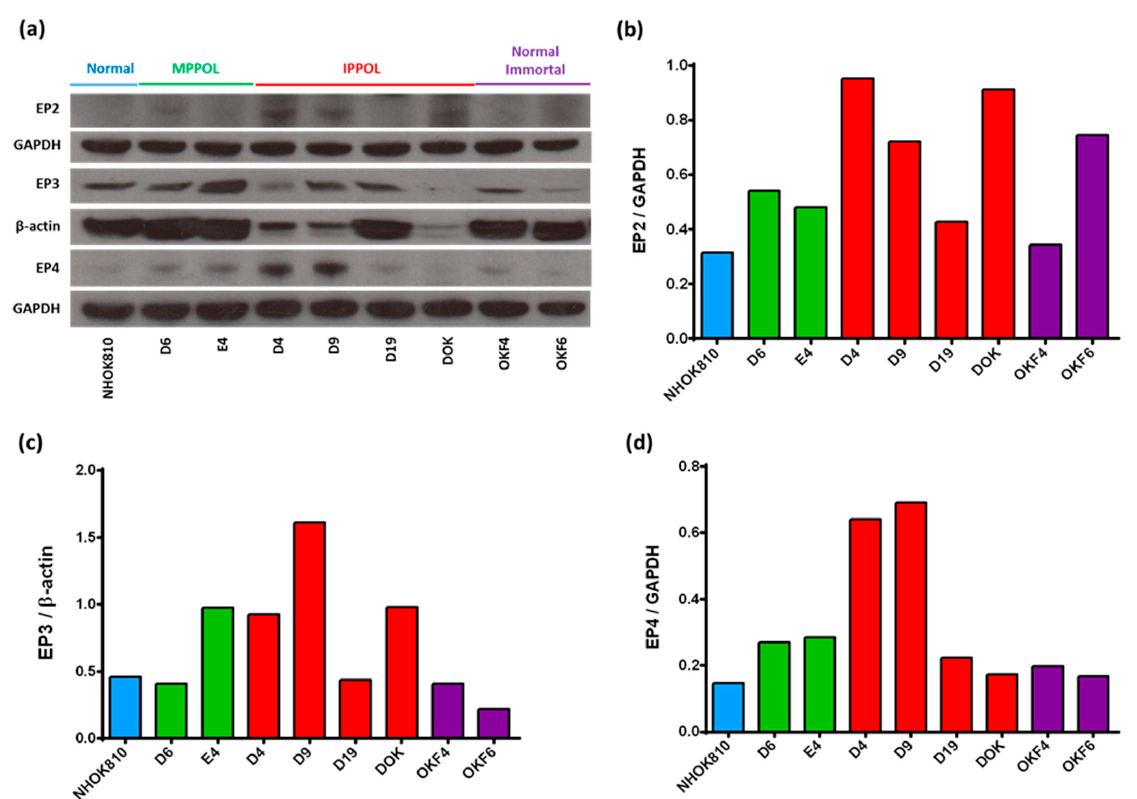
Figure 8. ( a ) Western blot showing the levels prostaglandin receptors (Eph 2-4; EP2, EP3 and EP4 in a selection of MPPOL, IPPOL and NOKs (Eph1 was not detected). GAPDH and beta actin were used as loading controls. ( b ) Quantitation of the EP2 levels in ( a ). ( c ) Quantitation of the EP3 levels in ( a ). ( d ) Quantitation of the EP4 levels in ( a ).